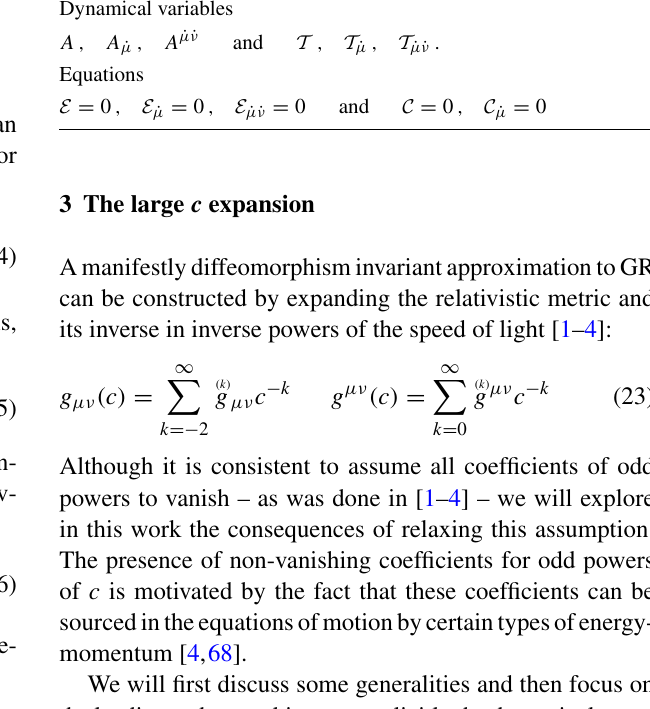
Table 1 GR formulated through a Newton–Cartan split Dynamical variables